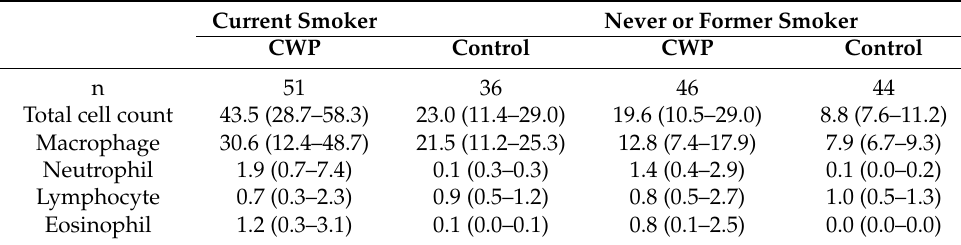
Table 1. Absolute numbers of cells in bronchoalveolar lavages obtained from patients with coal workers’ pneumoconiosis (n = 97) and control subjects (n =